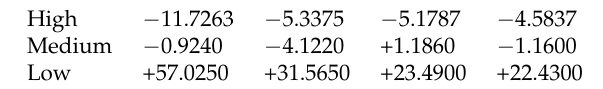
Figure 9. Quality satisfaction using an sequential single-item approach (SSI) auction. Table 3. Percentage deviation from the quality satisfaction using DYMO-Auction.